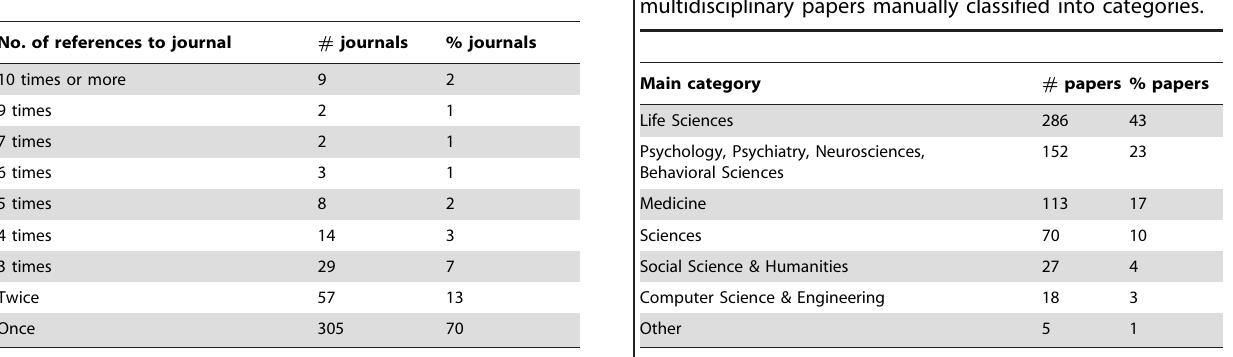
Table 4. Subject categories for journals cited at least twice in the 5 most recent blog posts for the 126 blogs